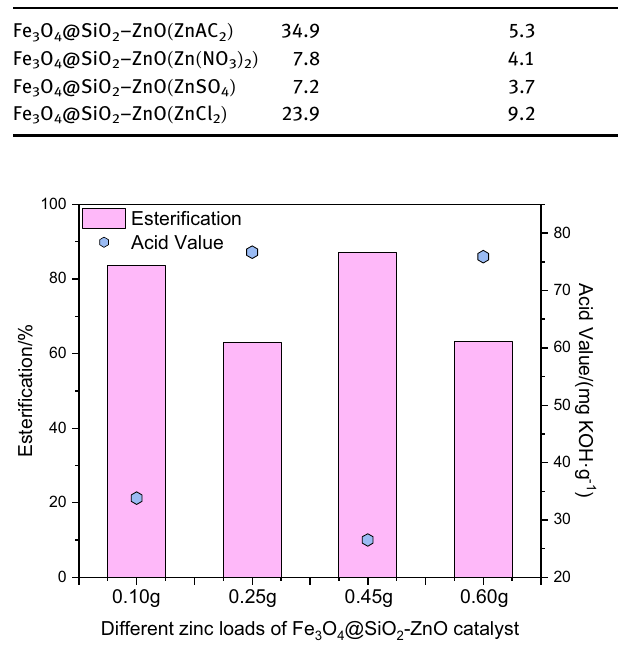
Figure 6: The e ff ects of di ff erent loadings on the reaction of rosin glycol esters ( rosin 15.0 g, ethylene glycol 1.7 g, catalyst 0.2 g, T 270°C, t 5 h ) .